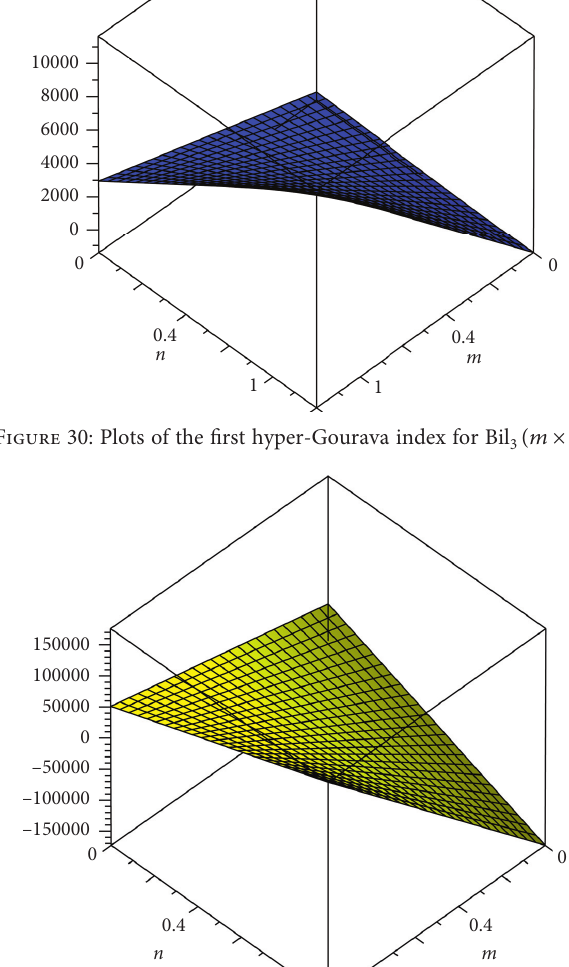
Figure 31: Plots of the second hyper-Gourava index for Bil